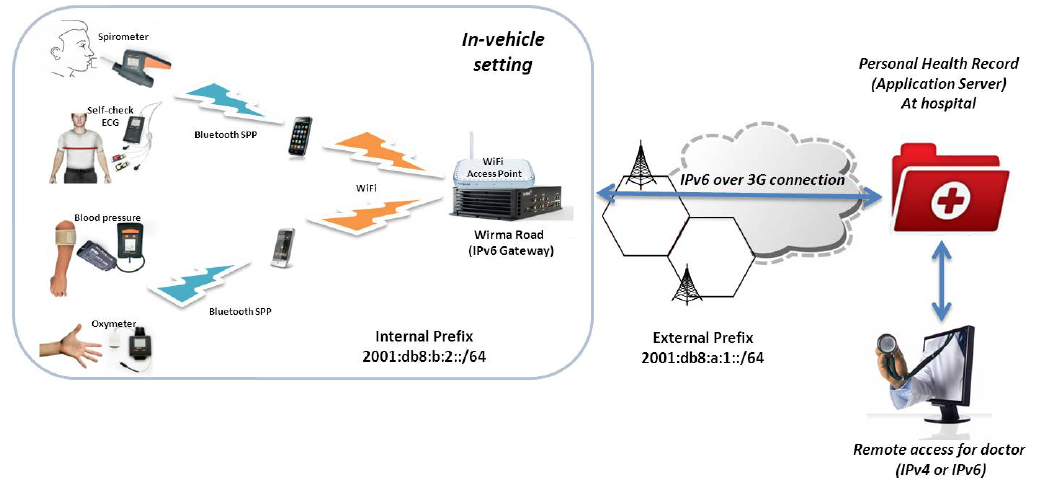
Figure 4. eHealth mobile operational scenario. Vital signs recorded by the patient are sent to the expert for diagnosis.